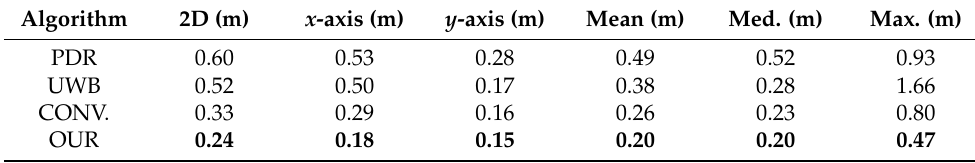
Table 3. Positioning errors in single-lap NLOS scenario.